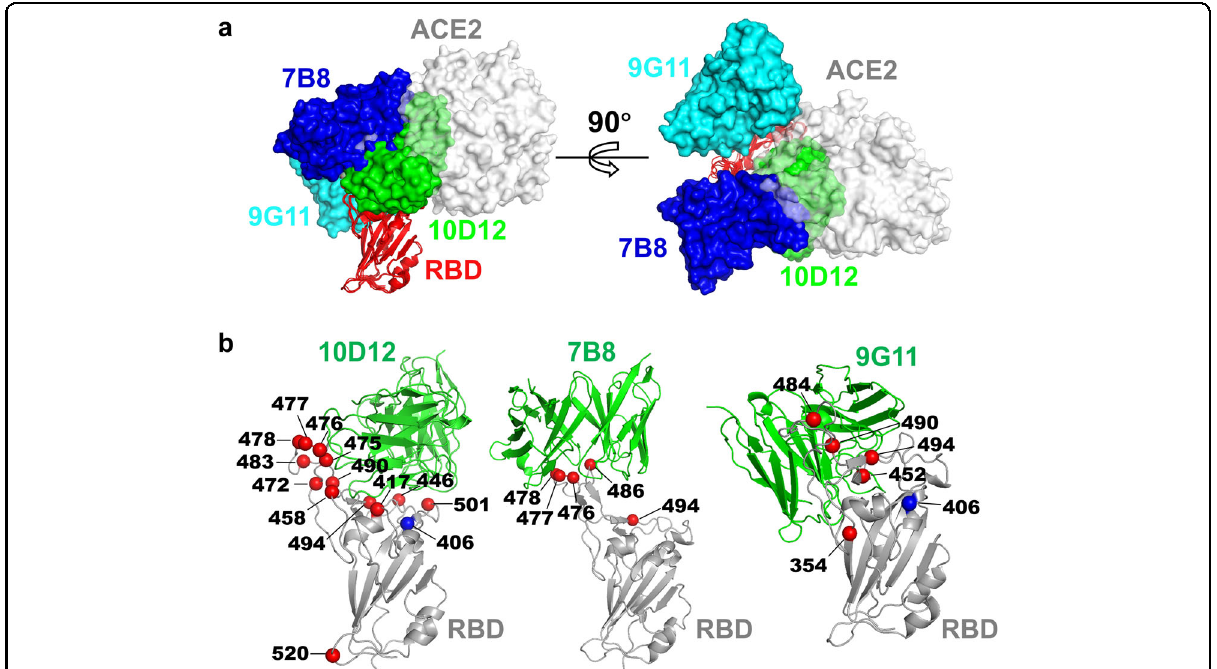
Fig. 4 The structural basis for antibody cocktails to reduce the escape of viral mutants. a Variable regions of three selected neutralizing antibodies and hACE2 (PDB:6M0J) are shown as surfaces and superimposed based on RBD to demonstrate their relative positions and orientations. b The landscape of mutations in SARS-CoV2 RBD that affect the neutralizing activity of individual antibody clones. The residues that affected the neutralizing activity in Fig. 3 are shown as red spheres, except residue 406, which is highlighted as a blue